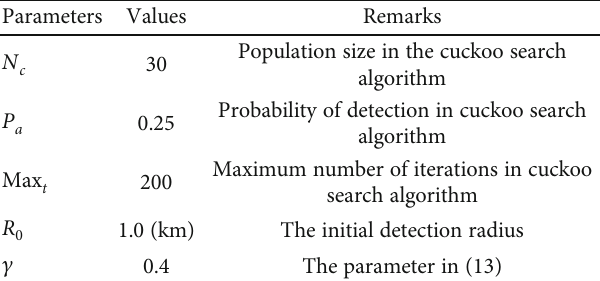
Figure 7: The pseudocode of the proposed allocation algorithm within a group. Table 1: Parameters of the proposed method. Parameters